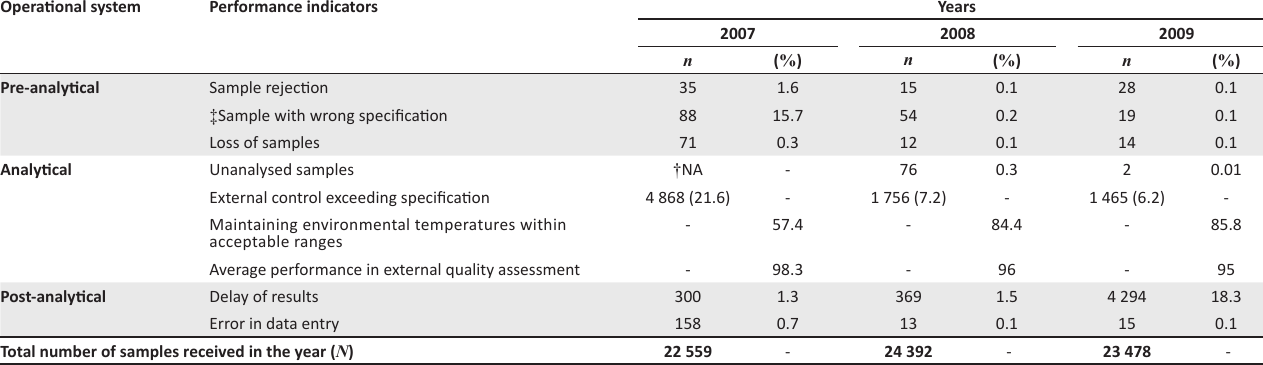
TABLE 1 : Performance of some indicators in the operational system between 2007 and 2009 for all assays in HVL. Operational system Performance